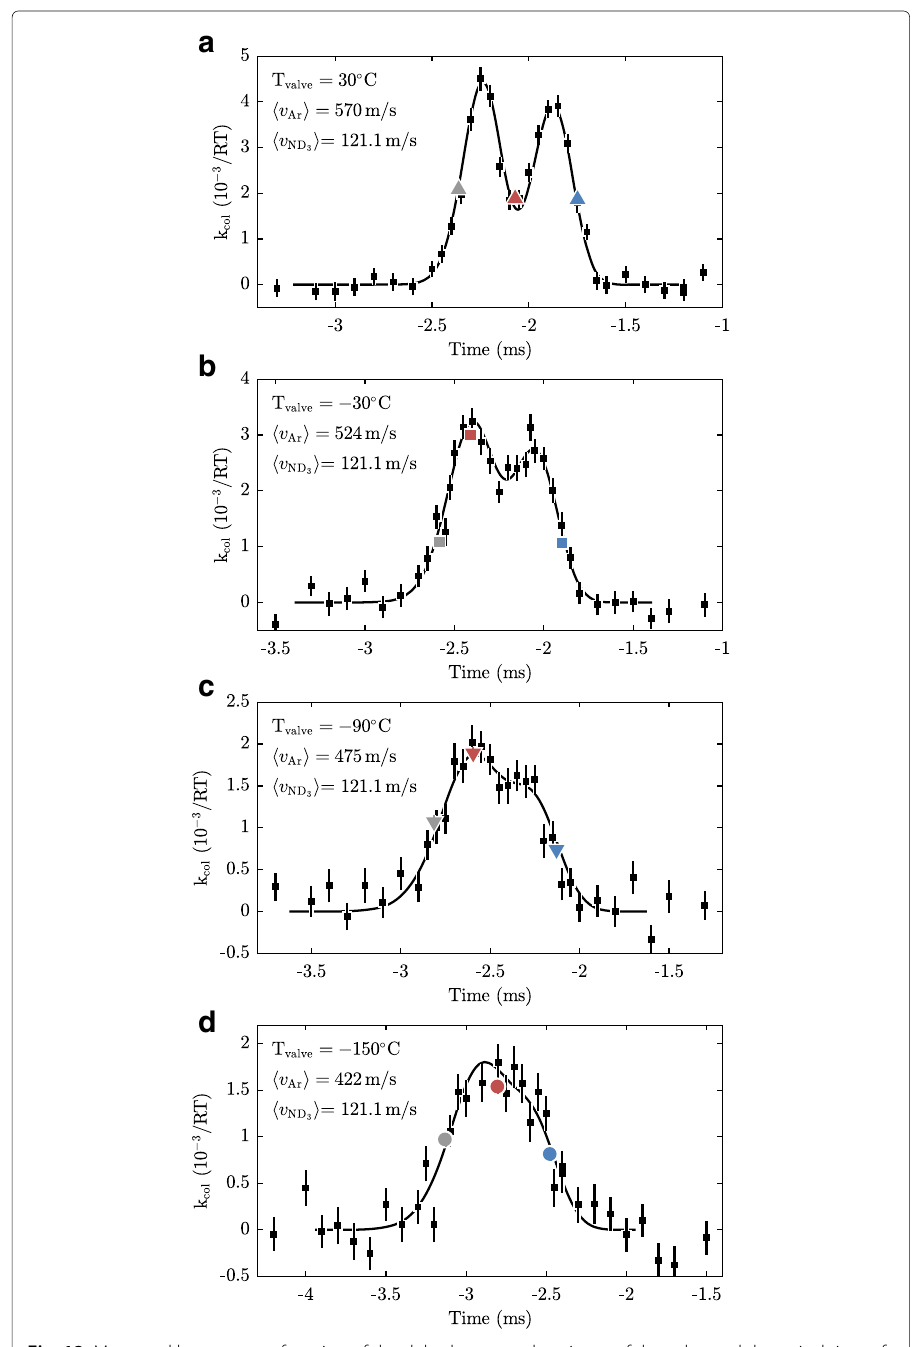
Fig. 12 Measured loss rate as a function of the delay between the trigger of the valve and the arrival time of = 121.1 m/s. Panels a – d depict measurements with the ammonia packets at the detection zone, for v ND 3 different temperatures of the valve housing that result in different average velocities as indicated in the top left corners. The black squares represent measurements containing 2400 shots each, while the coloured points represent measurements containing 21,600 shots each. The error bars, for the coloured points obscured by the symbols, denote the standard errors. The black lines show the results of simulations described in “Model to extract the relative cross section from the measured loss rates” section, scaled to fit the data in each panel. The reduced χ 2 ’s of the fits are 0.93, 1.01, 1.09, and 1.31 for panels a – d ,